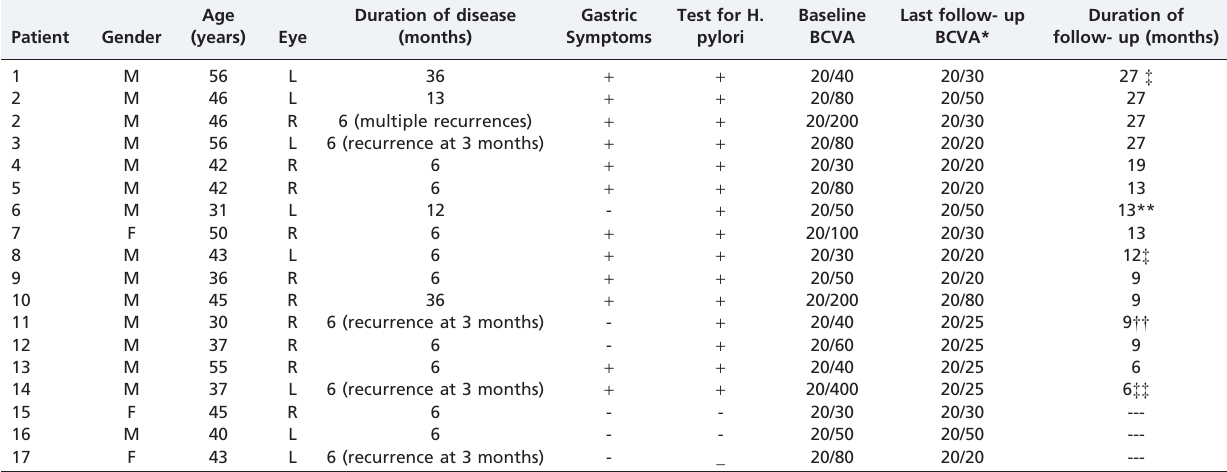
Table 1 - The results of the follow-up of 17 patients (18 eyes) diagnosed with central serous chorioretinopathy (CSC) who were screened and treated for gastric infection with Helicobacter pylori